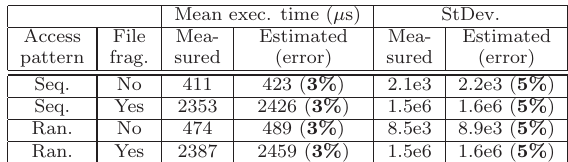
Table 3: Validation results: measured vs estimated. T overhead is found by reversing the preceding equation :